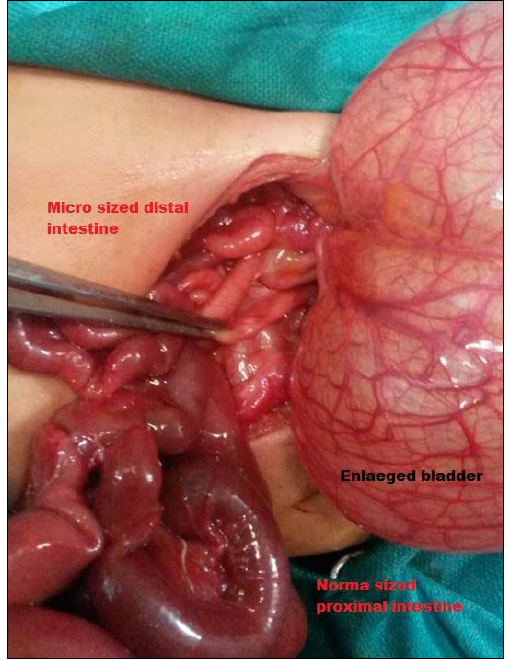
Figure 1: Distended urinary bladder and disparity in size between proximal and distal